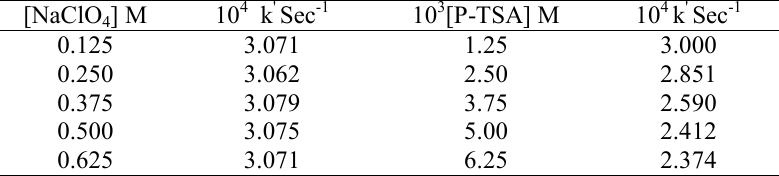
Table 2 . Effect of varying ionic strength and [P-TSA] on the reaction rate.